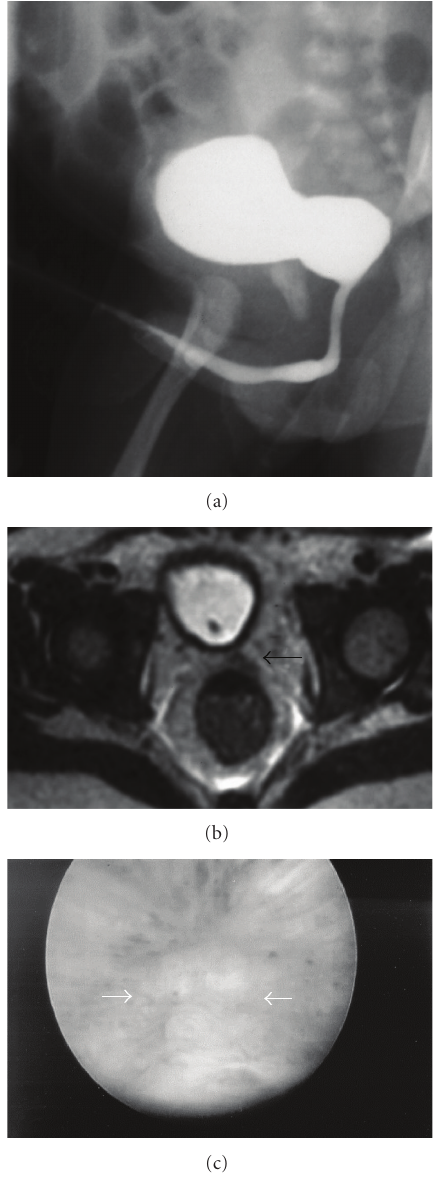
Figure 1: Voiding cystourethrography, magnetic resonance imag- ing, and urethroscopy in prune-belly syndrome. (a) In a 2-month- old child, the voiding phase of cystourethrography shows a large bladder neck without VM salience in the posterior urethra. (b) In the same patient at the age of 10, T2-weighted axial scan shows the absence of the right deferent and seminal vesicle, while the left seminal vesicle is tubular (black arrow) and the prostate gland is not detected. (c) Urethroscopy confirms the verumontanum hypoplasia, which is quite appreciable